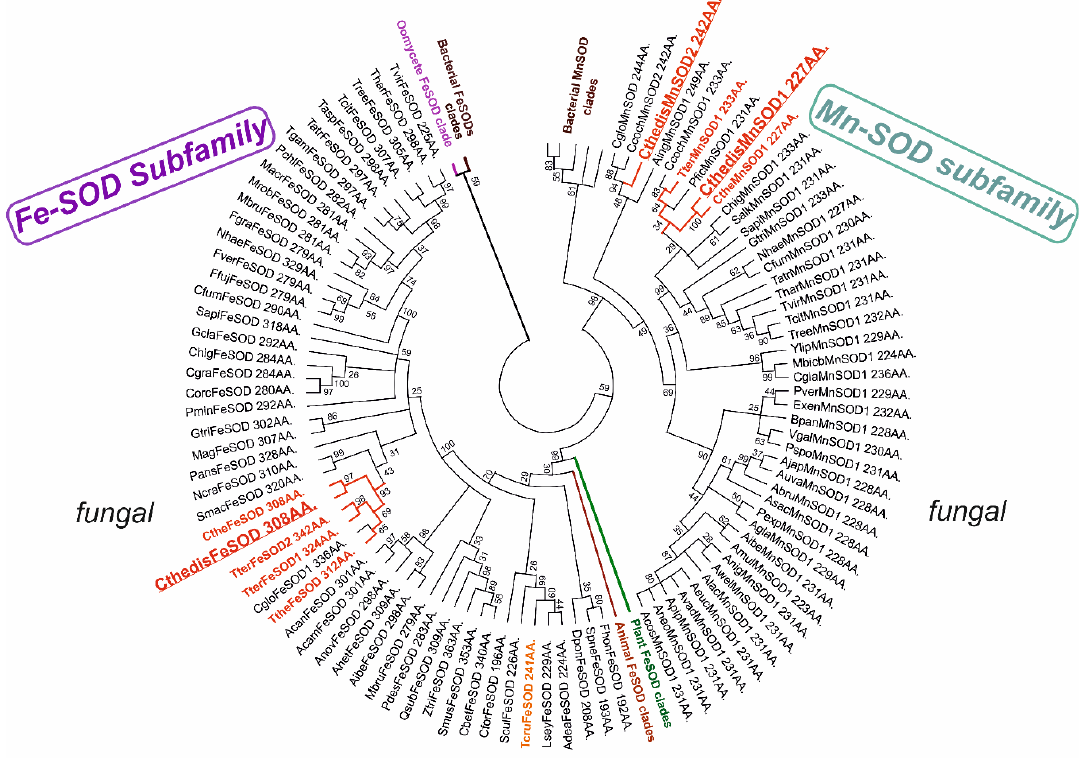
Figure 4. Global phylogenetic tree of 524 members of the Fe-MnSOD family obtained with the Maximum Likelihood method of MEGA-X package [15] by using Le Gascuel model of substitutions. Partial deletion with 38% sites coverage and 100 bootstrap replications were used in this reconstruction. Only bootstrap values above 25 are shown. There were in total 223 amino acid positions used in the final dataset. Sequences from thermophiles are labeled in red. Abbreviations of used sequences are explained in Table S3.